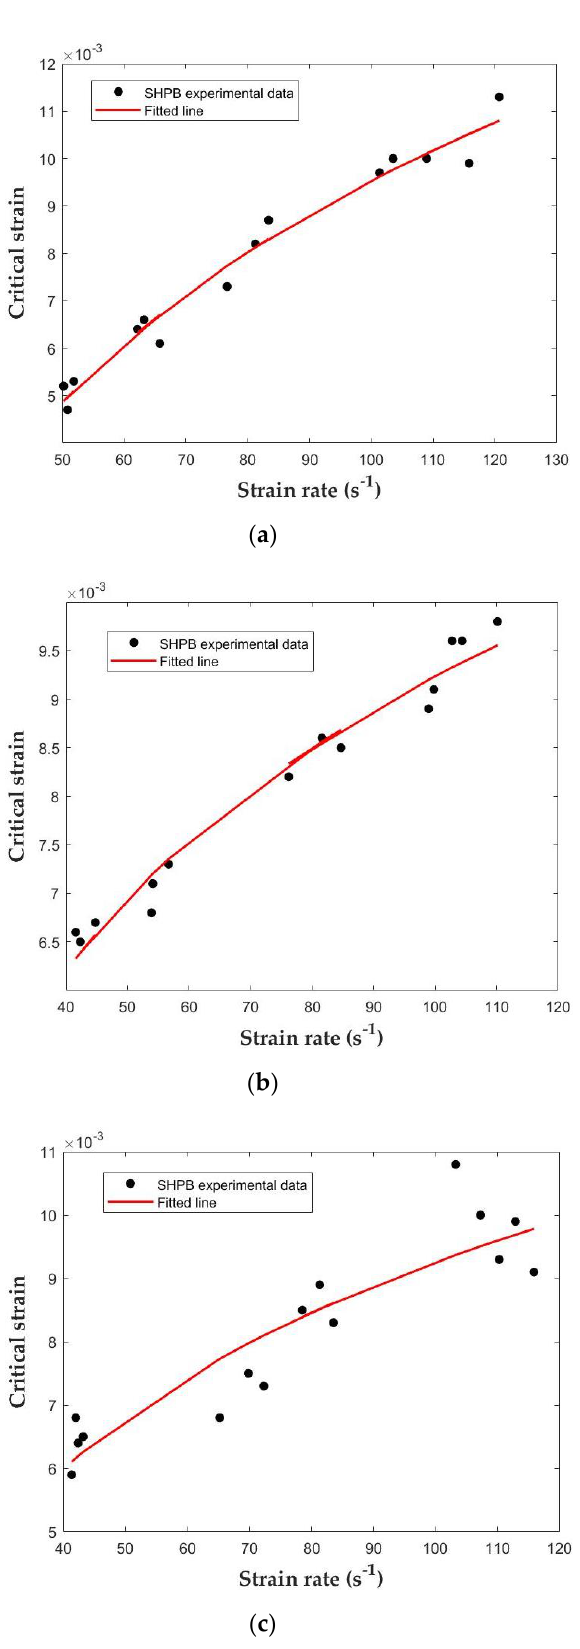
Figure 12. Fitted relationship between critical strain and strain rate: ( a ) Concrete series I; ( b ) Concrete series II; ( c ) Concrete series III.